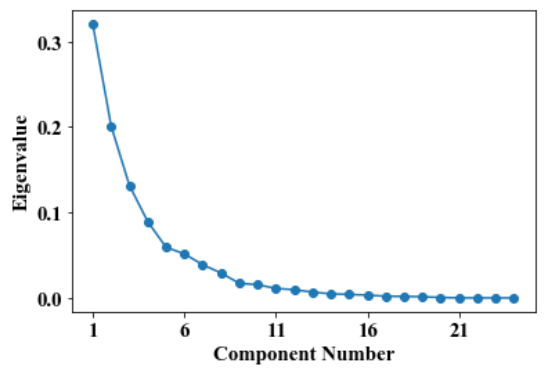
Figure 2. Scree plot of OFDF dataset.